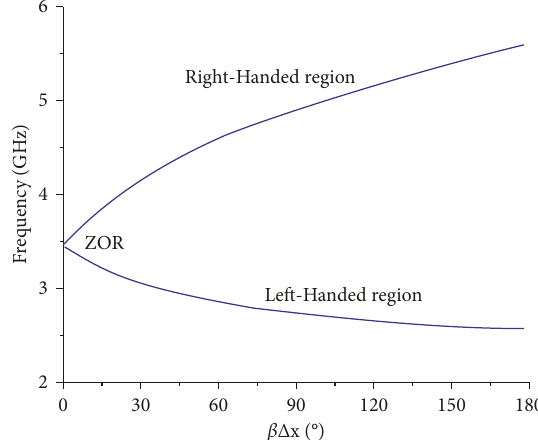
Figure 3: Dispersion diagram characteristic of the proposed CRLH-TL antenna.